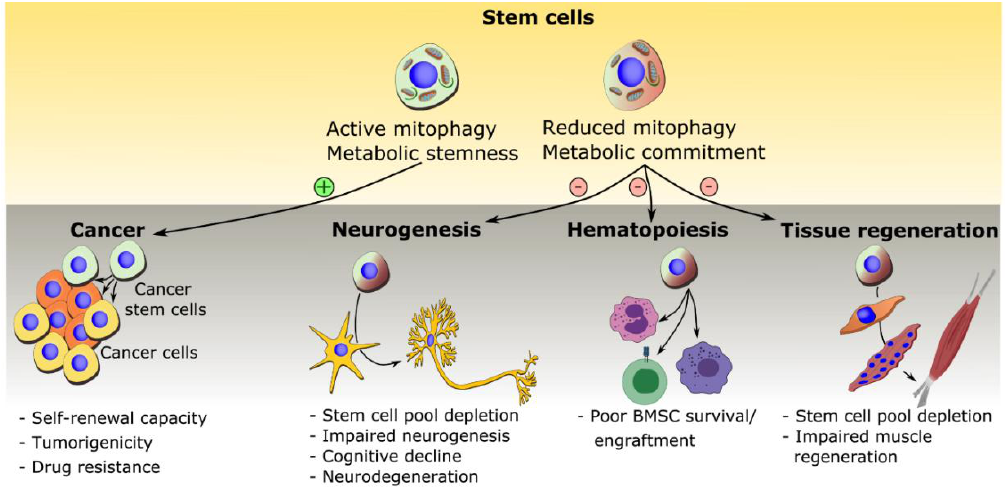
Figure 4. Stem cell mitophagy: implications in diseases. Emerging evidence indicate links between stem cell mitophagy and the development of disease. In the central nervous system, reduced mitophagy is neural stem cells is suggested to lead to depletion of the neural stem cell pool, which in turns leads to impaired neurogenesis [113–117].